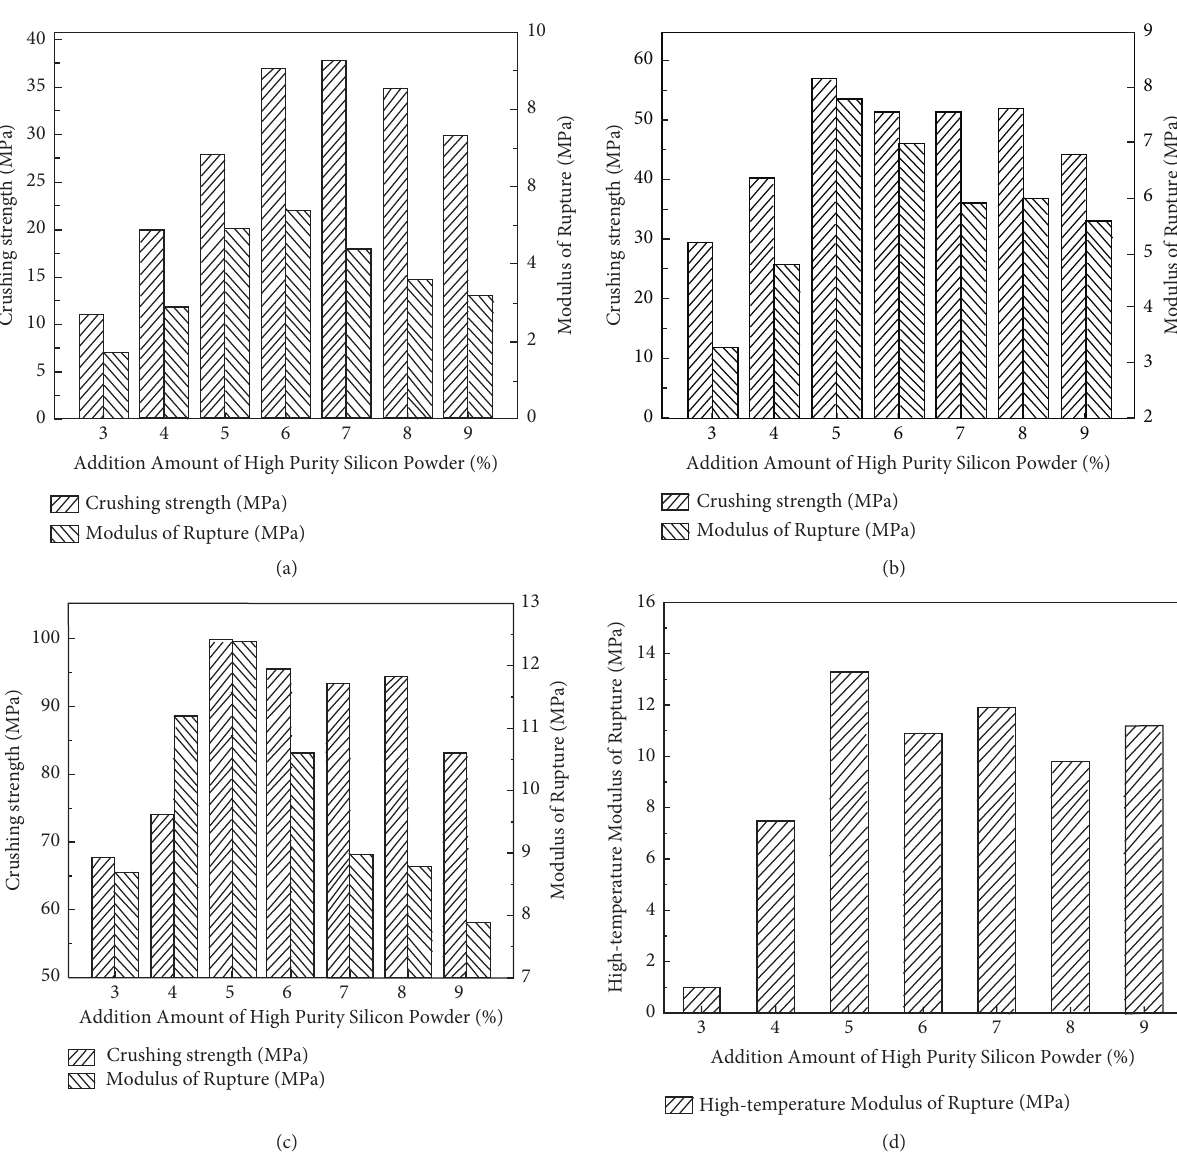
Figure 4: Mechanical properties of specimens treated at different temperatures: (a) compressive and flexural strength of samples dried at 110 ° C for 24h; (b) compressive and flexural strength of samples sintered at 1000 ° C for 3h; (c) compressive and flexural strength of samples sintered at 1450 ° C for 3 h; (d) high-temperature flexural strength of samples sintered at 1400 ° C for